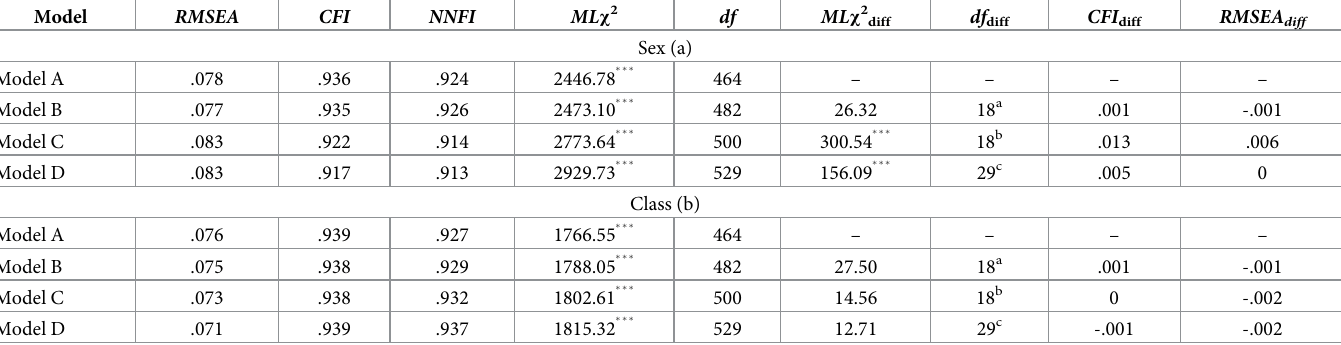
Table 5. Invariance analysis as a function of sex (Males vs females), and class (C1 “I media” vs C2 “II media” vs C3 “III media”) of the HEXACO-MSI-E: Multi- group hierarchical confirmatory factor analyses goodness-of-fit